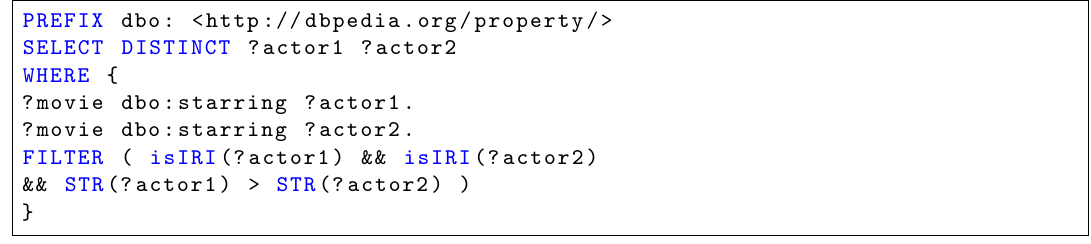
Figure 8. SPARQL query to extract co-acting social network from